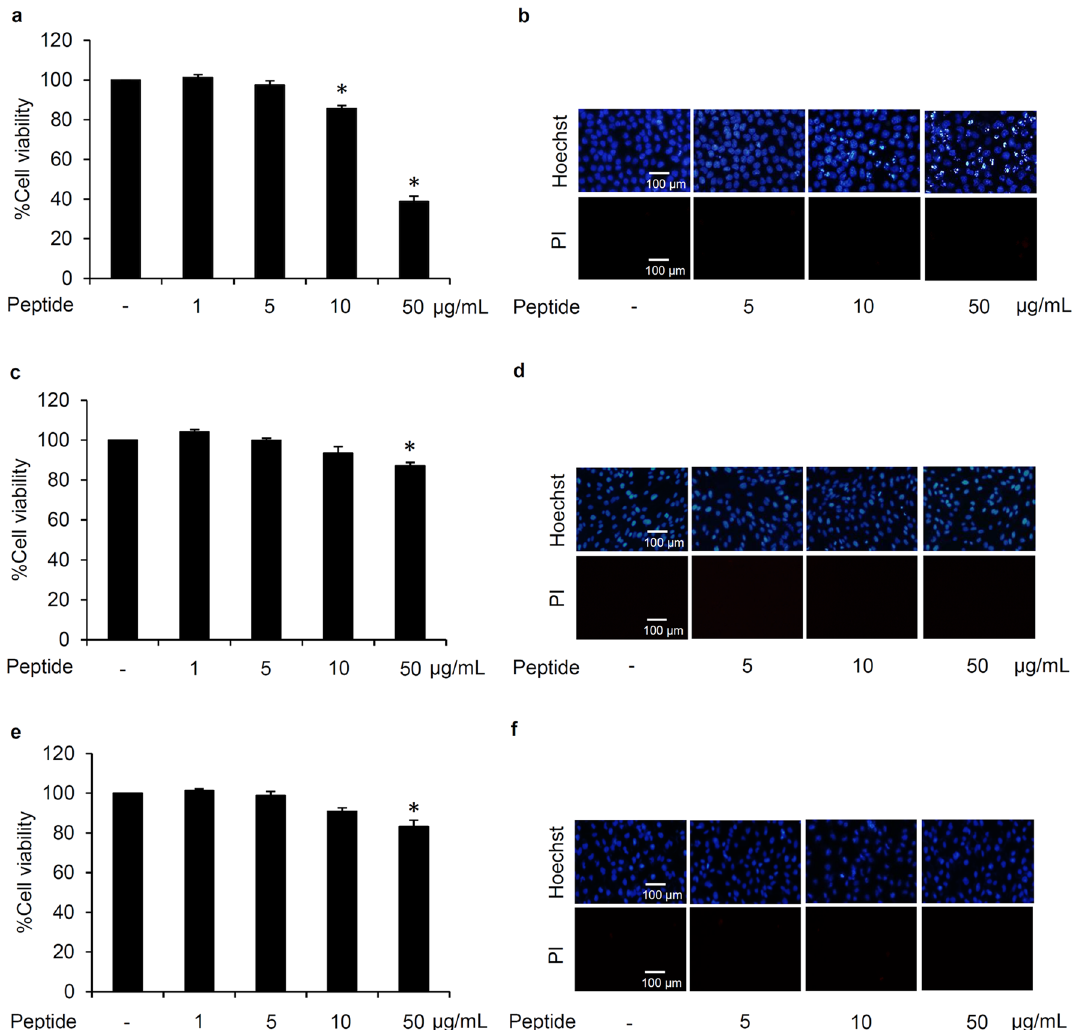
Figure 2. Cytotoxicity profile of L. squarrosulus peptide from 0.4 M NaCl fraction in human lung cancer and normal cells. The non-toxic concentration range of the peptide was determined in ( a ) human lung cancer H460, ( c ) dermal papilla DPCs, and ( e ) proximal renal HK-2 cells cultured with 0.4 M NaCl peptide (0–50 µg/ mL) for 24 h via MTT viability assay. Costaining with Hoechst33342 and propidium iodide (PI) indicated no detectable apoptosis and necrosis ( b ) H460, (d) DPCs, and (f) HK-2 cells after treatment with 5 µg/mL of 0.4 M NaCl peptide for 24 h. Notably, no cell death was observed in DPCs and HK-2 cells at higher concentrations of the peptide while apoptosis cells were visually in Hoechst33342-stained H460 cells cultured with 10–50 µg/mL of 0.4 M NaCl peptide. Values are means of three independent experiments ± SD. * p < 0.05 versus non-treated control